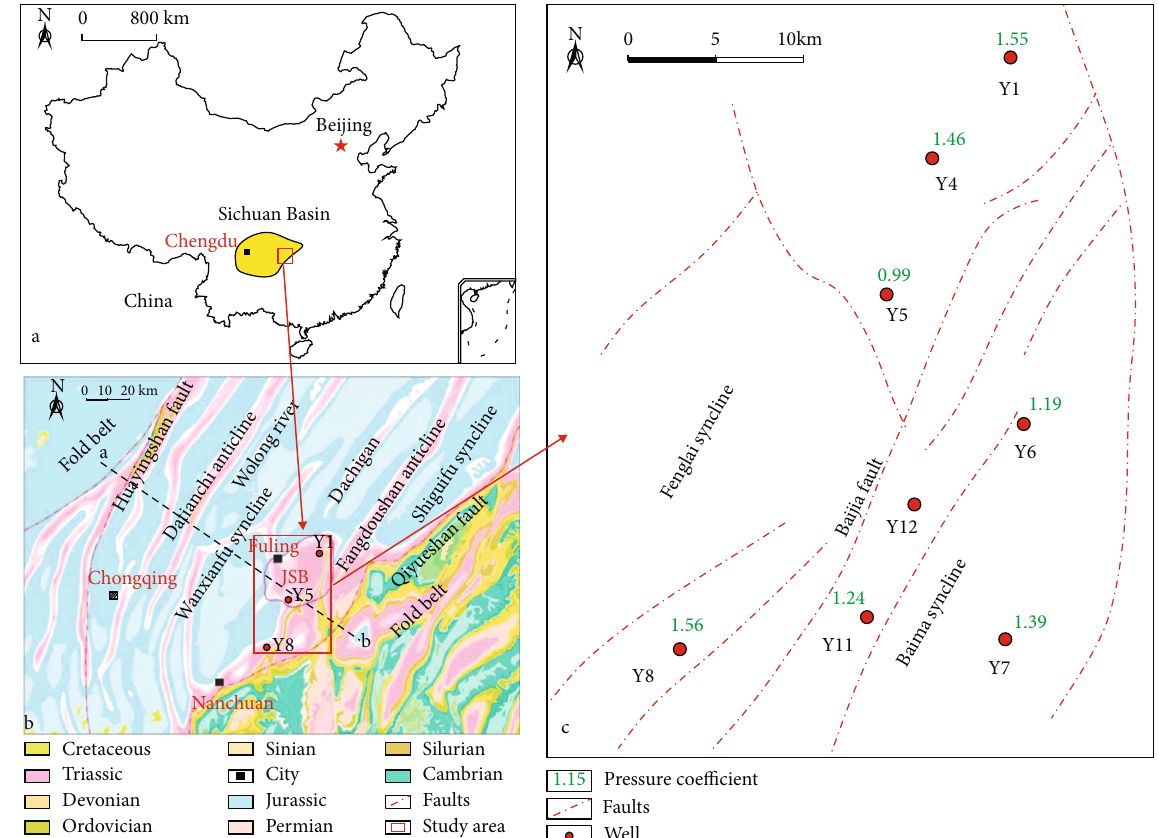
Figure 1: (a) Sichuan Basin; (b) the regional location of Fuling shale gas fi eld; (c) Faults distribution in the JSB area (modi fi ed after [30]).